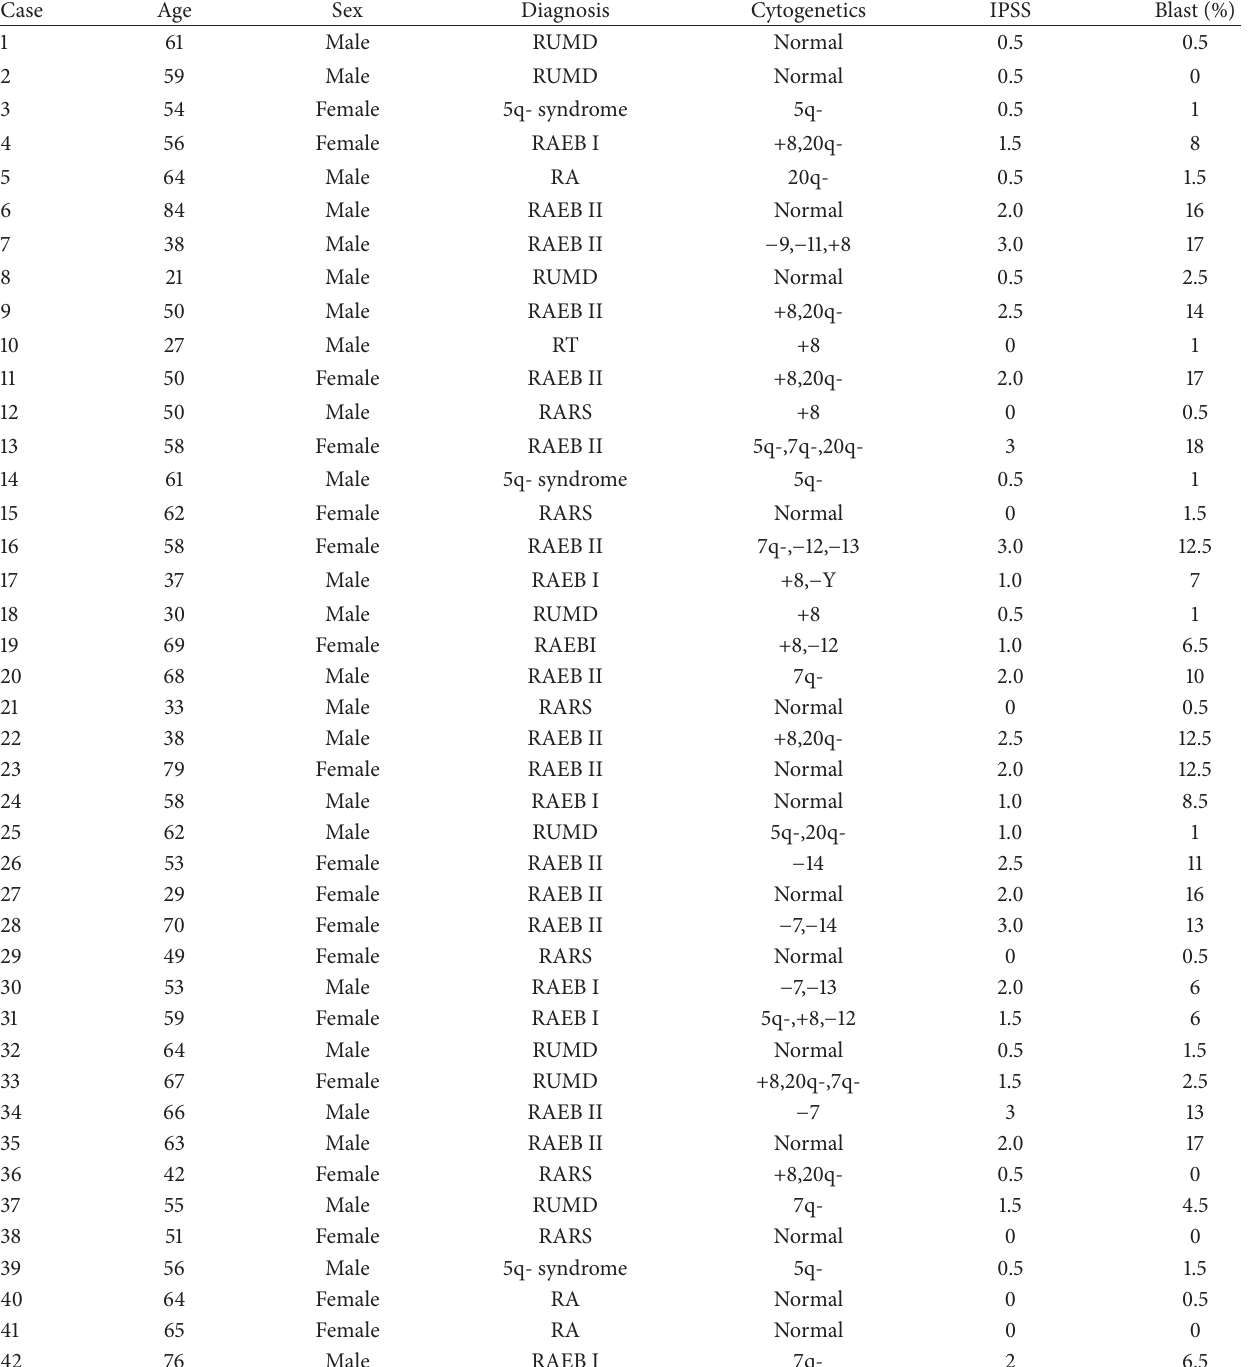
Table 1: Patient characteristics a